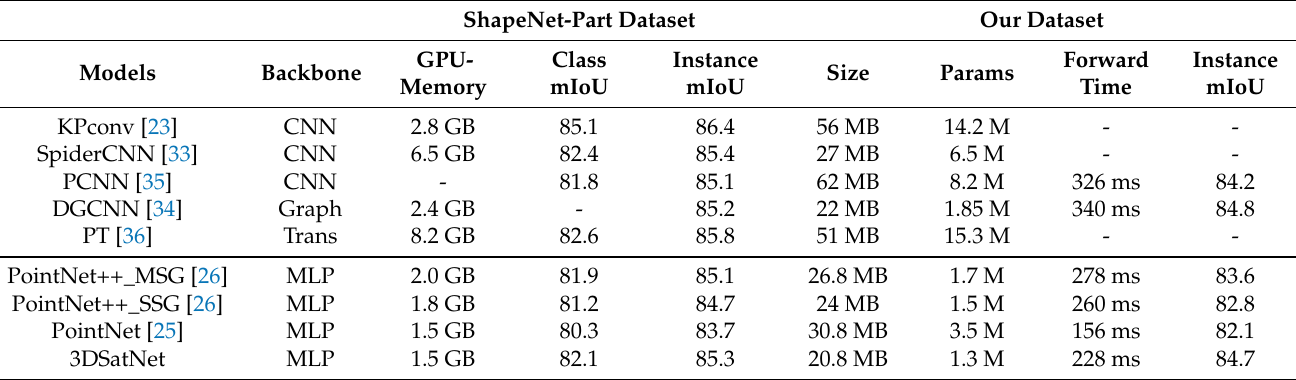
Table 4. Comparisons with the SOTA methods on the ShapeNet-Part dataset and 3D spacecraft component segmentation dataset